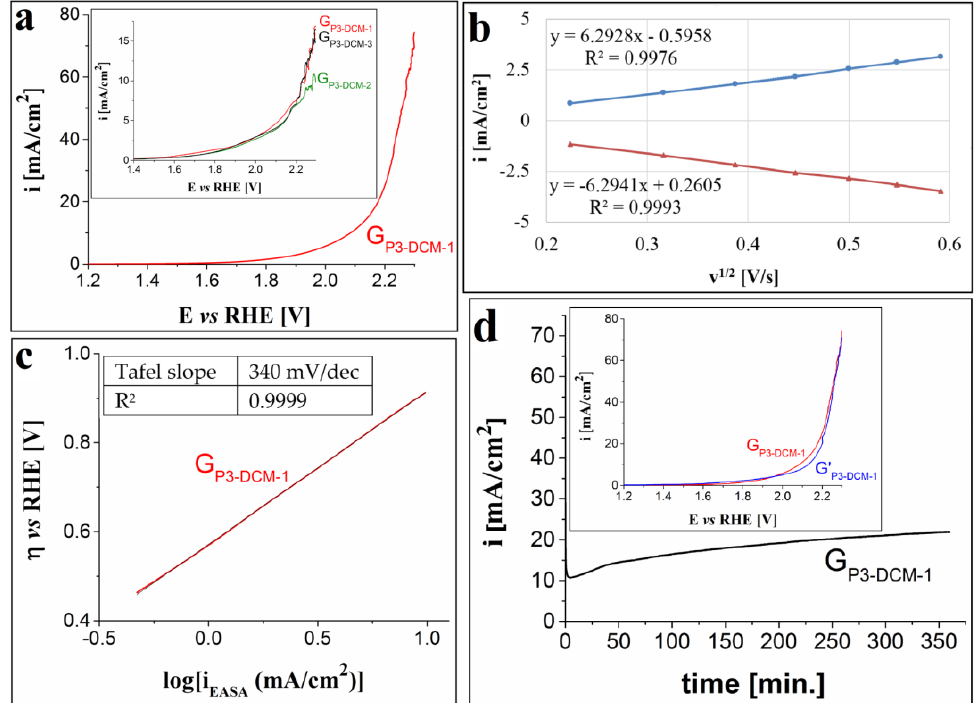
Figure 5. ( a ) Anodic polarization curve traced on the G P3-DCM-1 electrode in 1 M KOH solution, at v = 1 mV/s. Inset shows the LSVs recorded on the G P3-DCM-1 , G P3-DCM-2 and G P3-DCM-3 electrodes in 0.1 M KOH solution. ( b ) The dependence between the peak current densities of the anodic and cathodic peaks corresponding to the ferri-/ferrocyanide redox couple and the square root of the scan rate for the G P3-DCM-1 electrode. ( c ) The Tafel plot for the G P2-BN-1 electrode in 1 M KOH solution, with the current density values (i EASA ) obtained by taking into account the calculated EASA value. ( d ) i-time curve traced on the G P3-DCM-1 electrode in 1 M KOH solution and inset showing the LSVs recorded on the electrode before and after the stability test (coded as G P3-DCM-1 and G’ P3-DCM-1 ). Out of the three porphyrin modified graphite electrodes (G P1-DMF-3 , G P2-BN-1 and G P3- DCM-1 ) studied in 1 M KOH electrolyte solution in terms of their OER electrocatalytic prop- stability, the one manufactured using P1 is, overall, more performant than the others. This